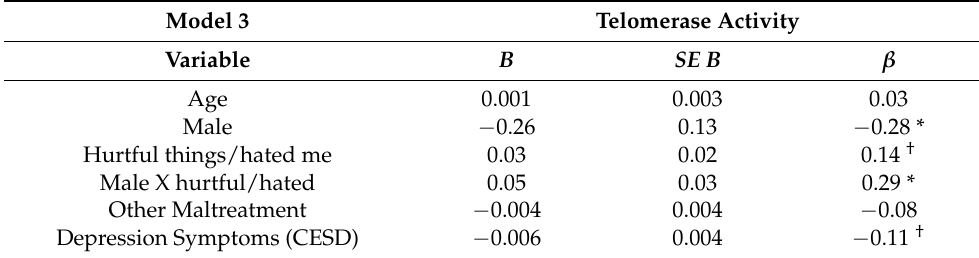
Table 3. Telomerase Activity and Emotional Abuse X Sex ( n =